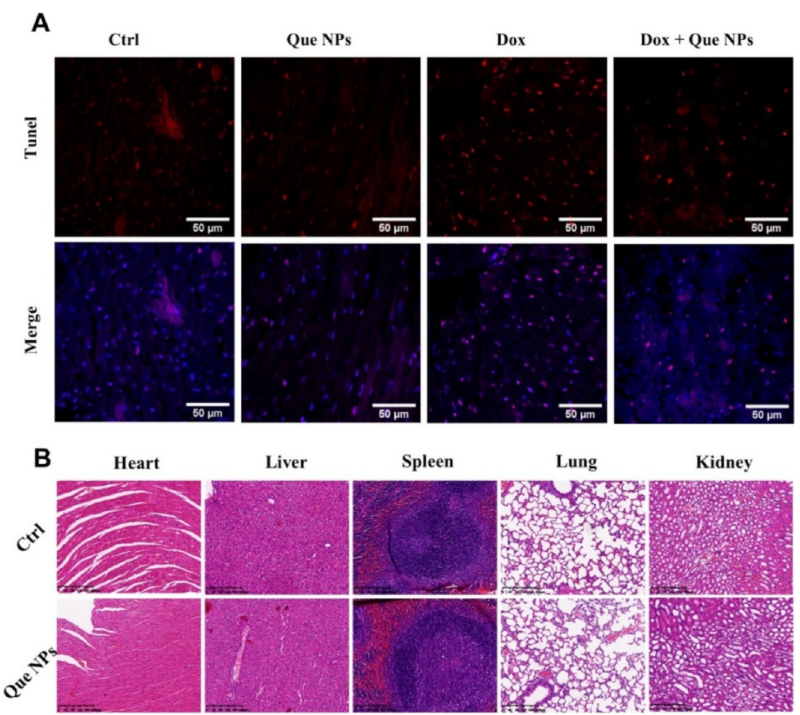
Figure 6. ( A ) Tunel staining of murine heart tissues; ( B ) representative HE staining pictures of murine major